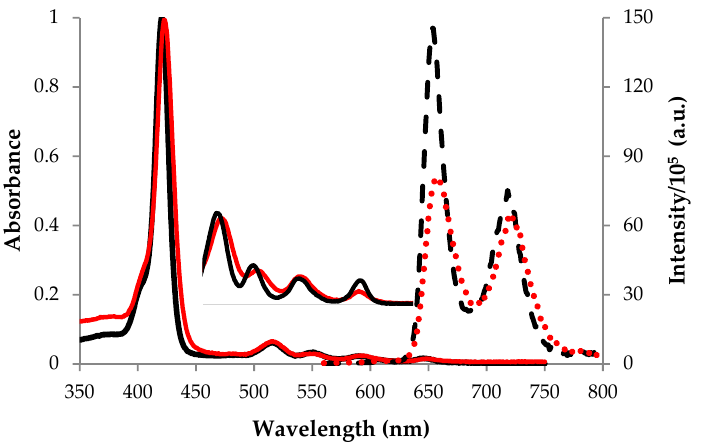
Figure 2. Absorption ( ‒ ) and fluorescence emission (···) spectra of 2-TQP (red) and TPP (black) recorded at room temperature in tetrahydrofuran (THF) and deaerated toluene solutions, respectively. Absorbance was monitored from 350 to 750 nm and fluorescence emission upon excitation at 552 nm was monitored from 560 to 800 nm. Table 1. Photophysical properties of 2-TQP at room temperature a